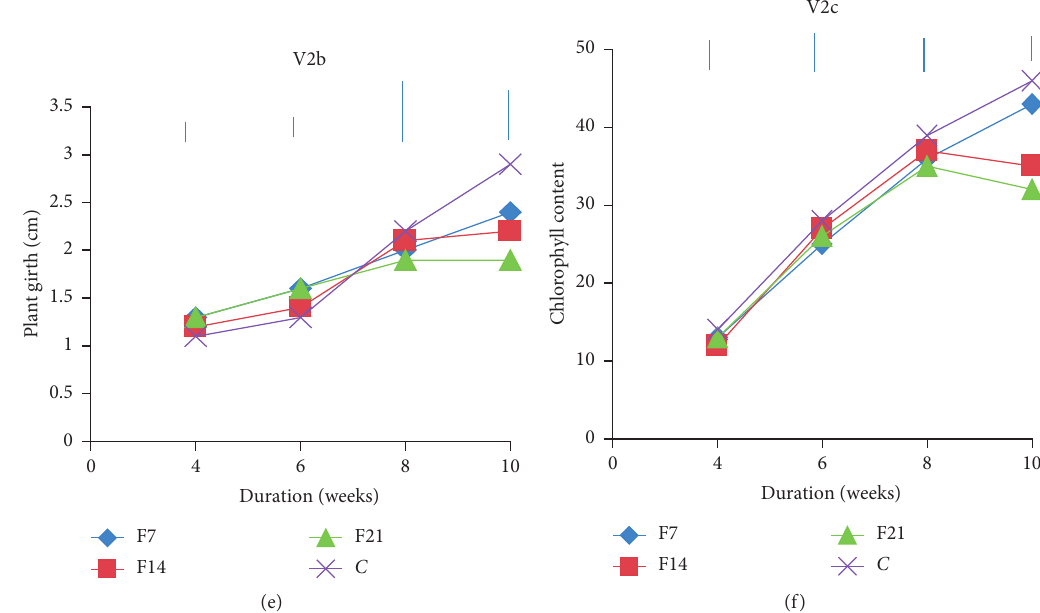
Figure 2: Plant height, girth, and chlorophyll content of Essoumtem V1a, V1b, and V1c and Clemson spineless V2a, V2b, and V2c okra plants inoculated individually and simultaneously with Meloidogyne incognita and Fusarium oxysporum f sp. vasinfectum on field. F � fungus alone; N � nematode alone; NF � nematode and fungus simultaneously; NF7 � fungus 7 days after nematode inoculation; NF14 � fungus 14 days after nematode inoculation; NF21 � fungus 21 days after nematode inoculation; and C � control Table 5: Fresh and dry shoot weights for “Essoumtem” and “Clemson spineless” under four inoculations in field experimentation. Type of inoculation